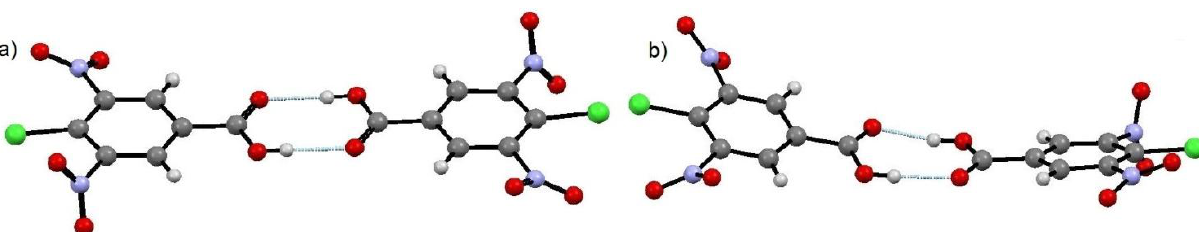
Figure 9. Hydrogen bonded dimer of 4Cl35DNBA in: ( a ) 4Cl35DNBA Form I; ( b ) 4Cl35DNBA Form